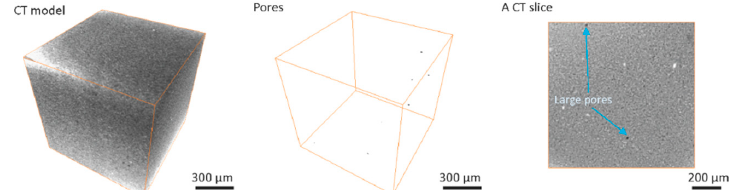
Figure 4. Computed tomography results for Al ₂ O ₃ sintered ceramic sample, manufactured with stereolithography-based additive technology, there are shown the original greyscale 3D image acquired with computed tomography (CT), the segmented round pores and a typical CT slice.